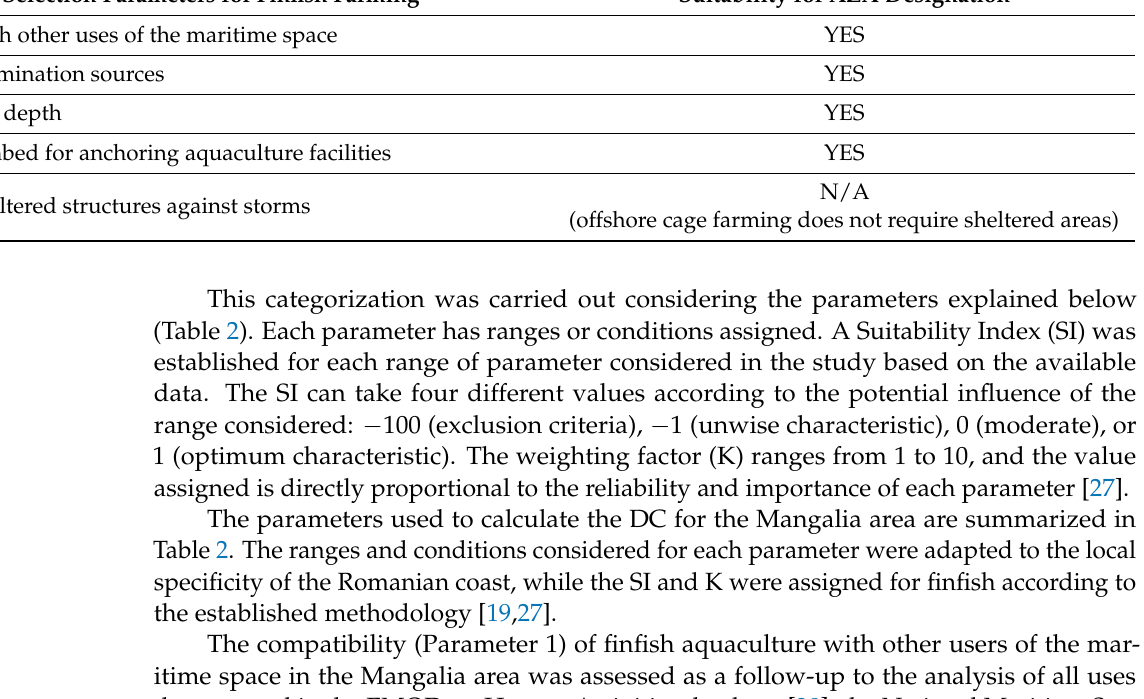
Figure 1. The location of the pre-selected polygon (Mangalia area, Romania) (source: Google Earth, 2023). Table 1. Pre-selection criteria of the proposed AZA for finfish farming (Mangalia) (adapted from [17]). Pre-Selection Parameters for Finfish